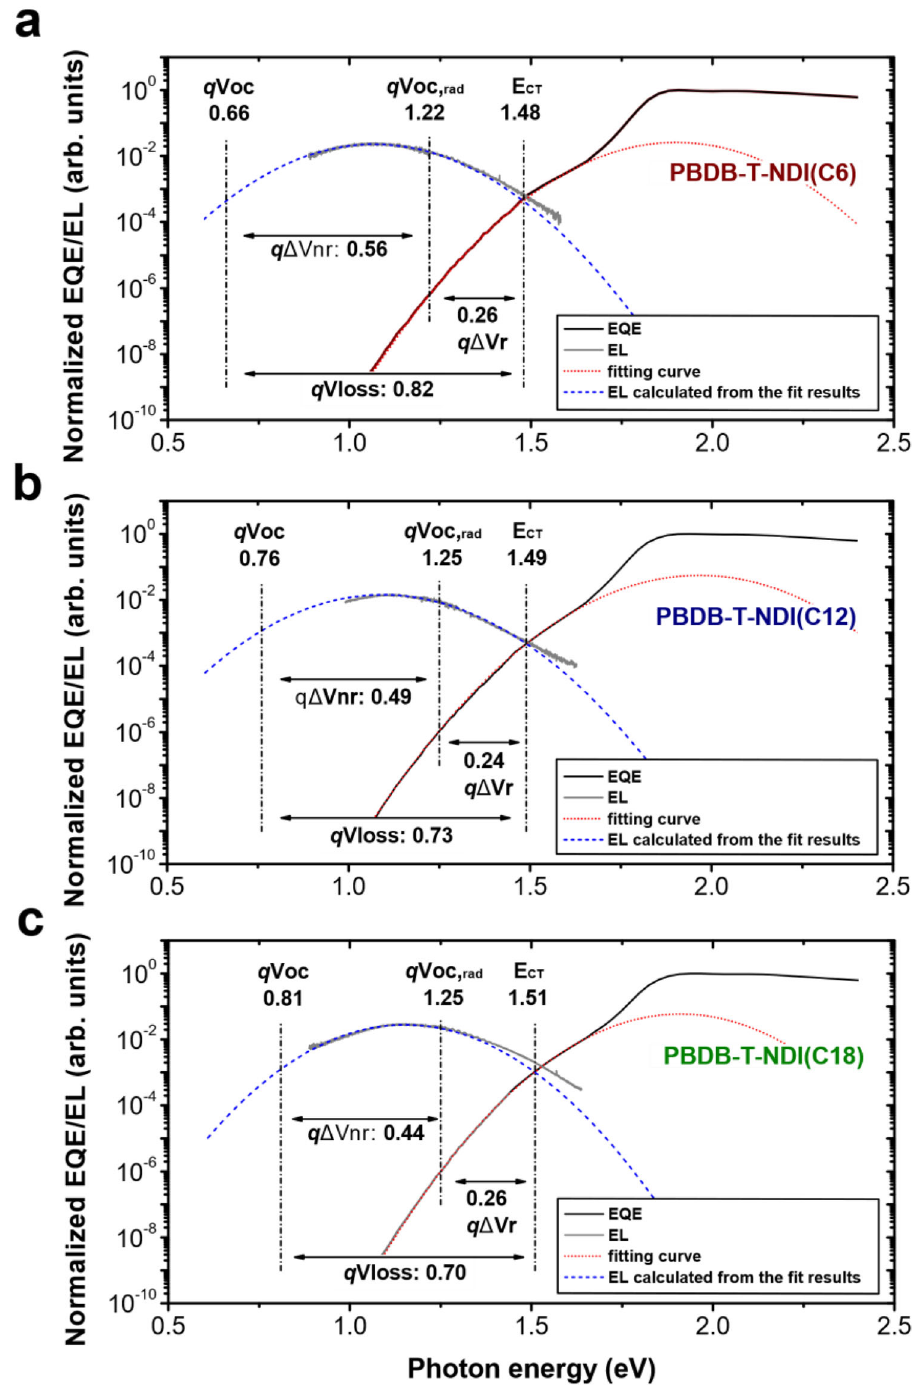
Fig. 2 Voltage losses and CT state properties in the solar cells based on DCDA polymers. EQE and electroluminescence (EL) spectra of the solar cells based on a PBDB-T-NDI(C6), b PBDB-T-NDI(C12), and c PBDB-T-NDI(C18). The lower energy parts of the EQE spectra are fi tted by using the method described in the literature 67 – 70 to determine the values for E CT , and the fi t results are used to calculate the emission spectra, which agree well with the measured EL spectra of the solar cells. Details regarding the determination of E CT are provided in Supplementary Note